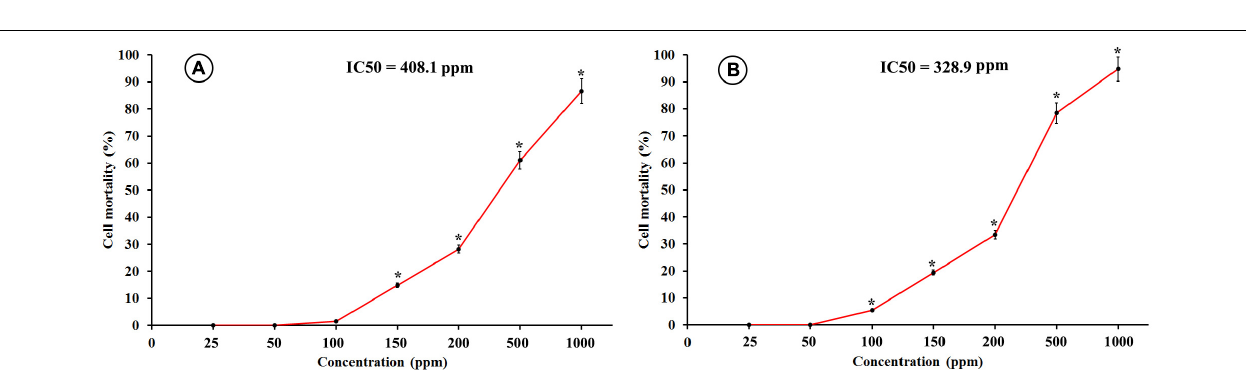
FIGURE 5 | Cytotoxicity of SiNPs at exposure time of 48 h on (A) kidney epithelial cells (Vero), and (B) lung epithelial cells (BEAS-2B). Values represent the means of three replicates ± SE. IC 50 = the half-maximal inhibitory concentration. ∗ = significant at p ≤ 0.05 compared with the untreated control.